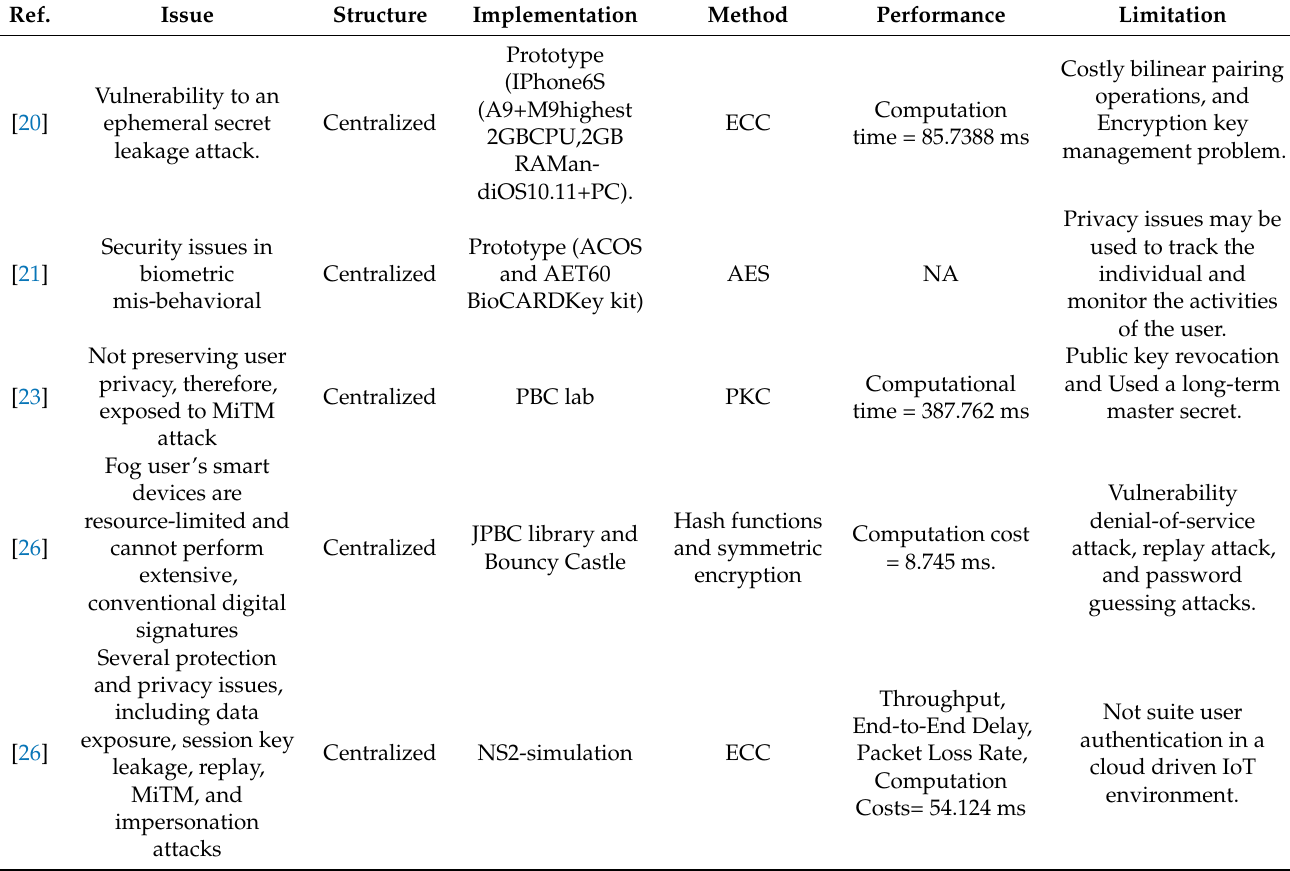
Table 1. Comparison of the existing authentication scheme in fog